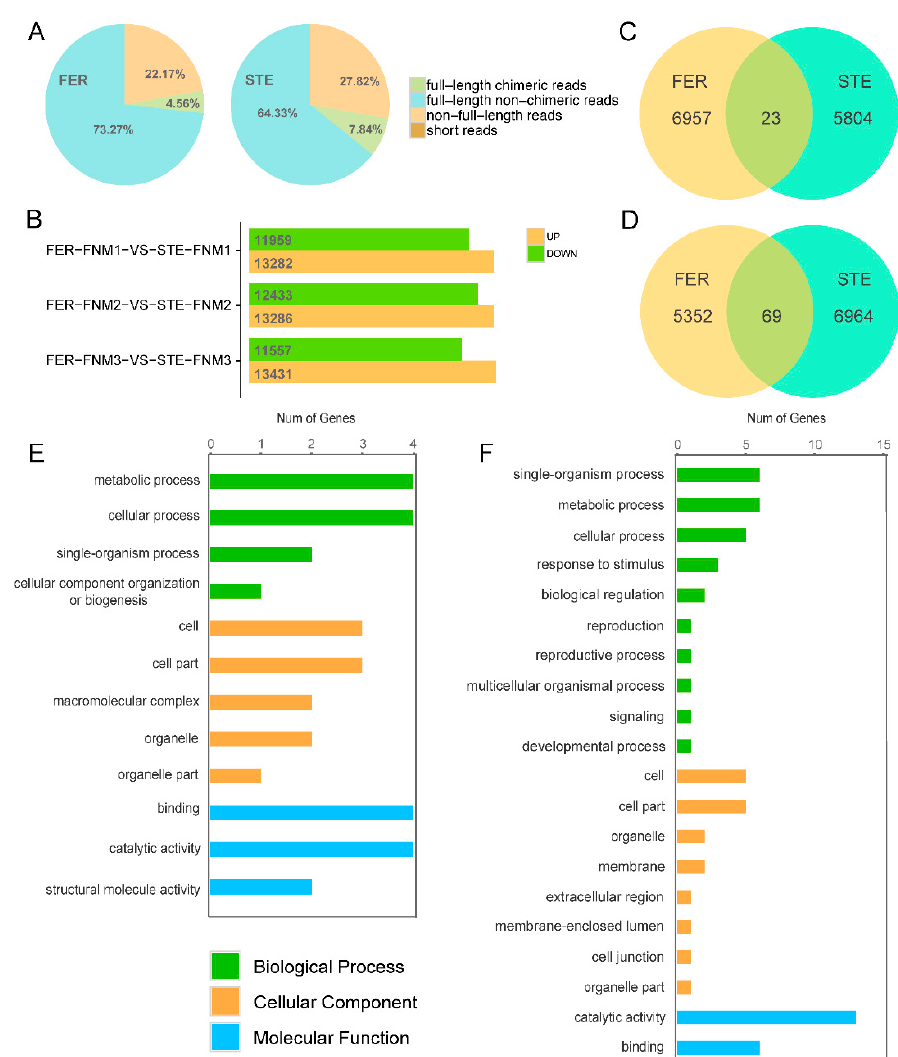
Figure 3. ( A ) Summary of SMRT sequencing proportions of four kinds of the circular consensus sequence (CCS), classified into full-length chimeras reads, full-length nonchimeric reads (FLNC), non-full-length reads, and short reads. ( B ) DEGs in each FNM period between FER and STE; ( C ) DEGs with opposite expression patterns during the FNM process in STE and FER, DEGs upregulated in FER and downregulated in STE; ( D ) DEGs upregulated in STE and downregulated in FER; ( E ) Gene Ontology (GO) classification of DEGs both upregulated in FER and downregulated in STE; ( F ) GO classification of DEGs both upregulated in STE and downregulated in